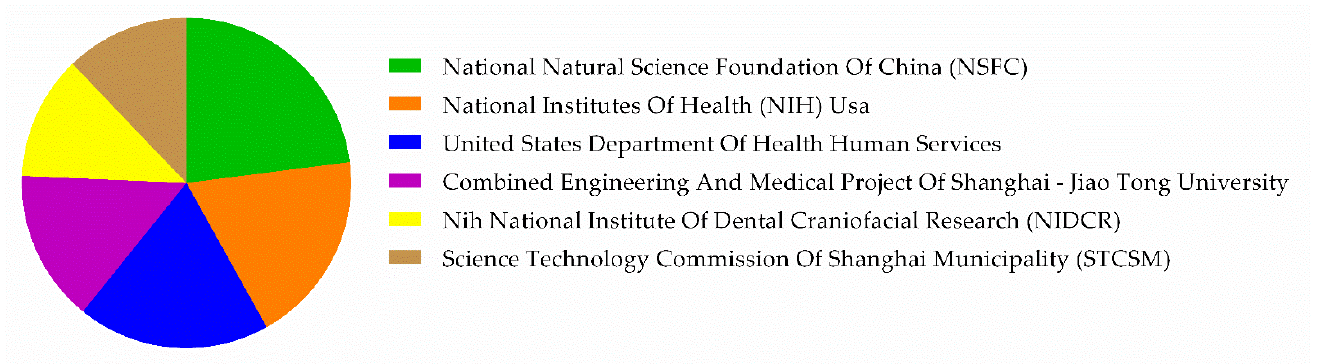
Figure 6. Main funding agencies in zygomatic implant research.